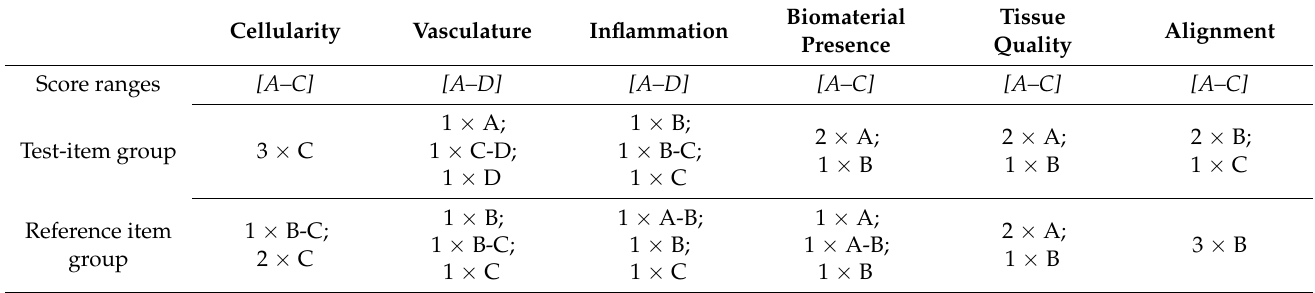
Table 3. Summary of the microscopic evaluation and scoring results of operated, treated, and harvested patellar tendons under high magnification, presented as a condensed contingency table for the three rabbits within each group. Independency between investigated parameters and study groups was assessed by using Fisher’s Test for exact count data. Ad hoc scoring definitions are presented in Table 3. Biomaterial Tissue Cellularity Vasculature Inflammation Presence Quality